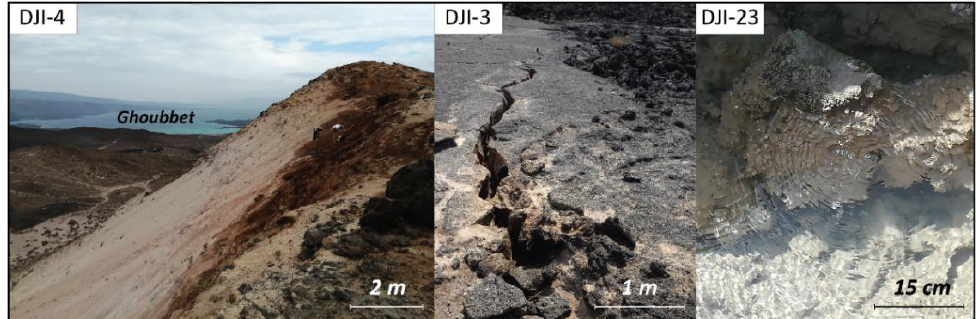
Figure 5. Photos of different sampling sites: fumaroles in highly altered rocks (DJI-4), a fumarole